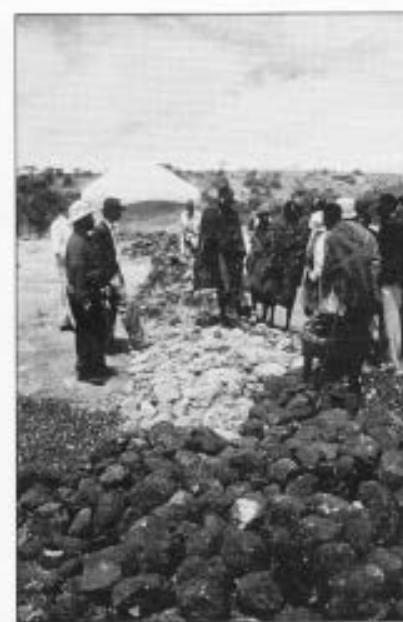
Figure 5 Laetoli, 1995: the trackway look­ ing north, showing different layers of the reburial stratigraphy,